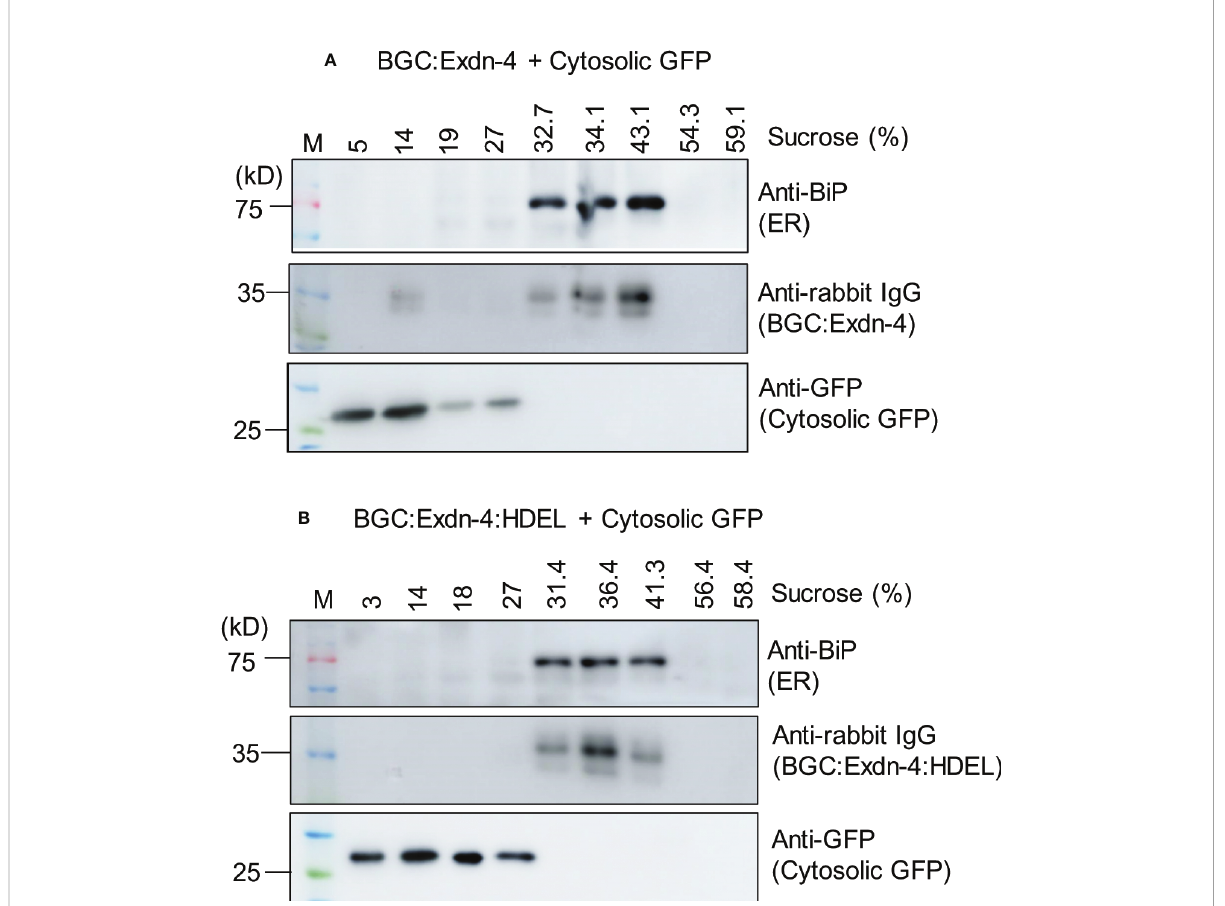
FIGURE 2 Both BGC : Exdn-4 and BGC : Exdn-4:HDEL expressed in N. benthamiana localize to the ER. (A, B) Subcellular fractionation and western blot analysis of BGC : Exdn-4 and BGC : Exdn-4:HDEL. Total protein extracts from leaf tissues of N. benthamiana expressing BGC : Exdn-4 and cytosolic GFP (A) , or BGC : Exdn-4:HDEL and cytosolic GFP (B) were fractionated using a linear sucrose gradient from 10 to 60% sucrose. These fractions were separated by SDS/PAGE and analyzed by western blotting using anti-BiP, anti-rabbit IgG and anti-GFP antibodies. ER proteins were detected in the fractions containing 32.7 to 43.1% sucrose (A) or 31.4 to 41.3% sucrose (B) whereas the cytosolic GFP was detected in the fractions 5 to 27% sucrose (A) or 3 to 27% (B) . These results indicate that both BGC : Exdn-4 and BGC : Exdn-4:HDEL localize to the